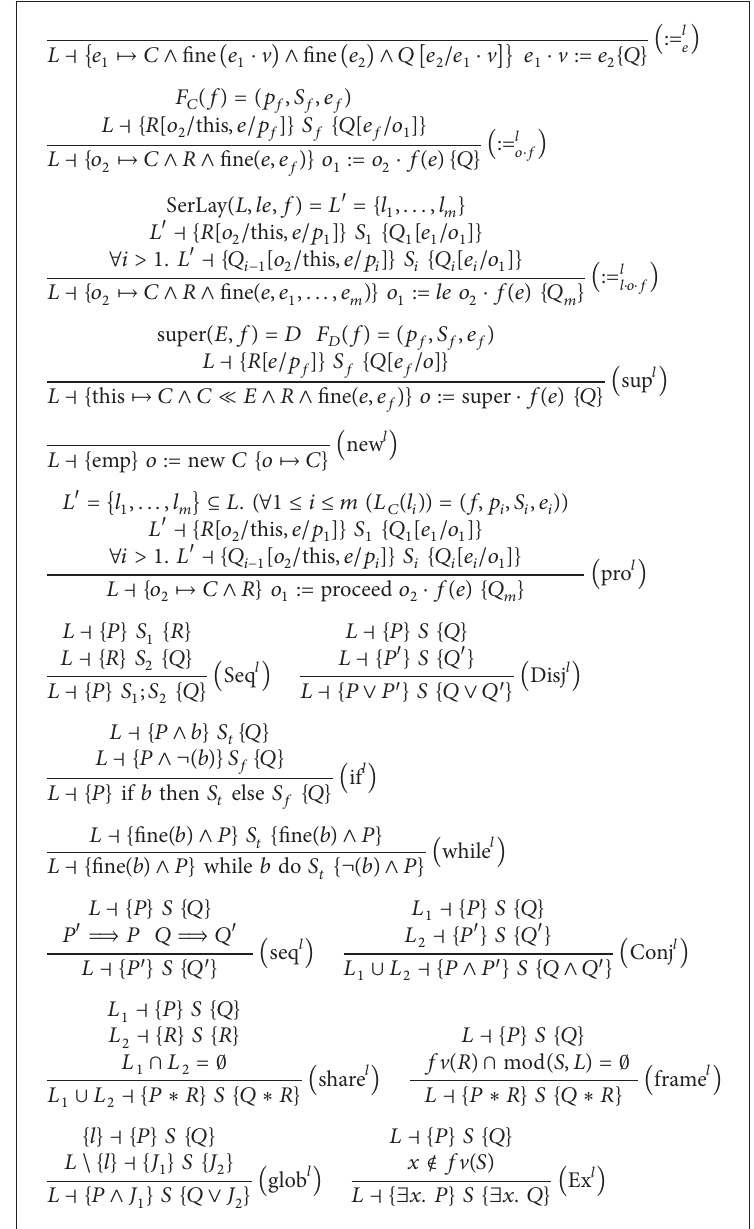
Algorithm 5: The inference rules of the proposed logical